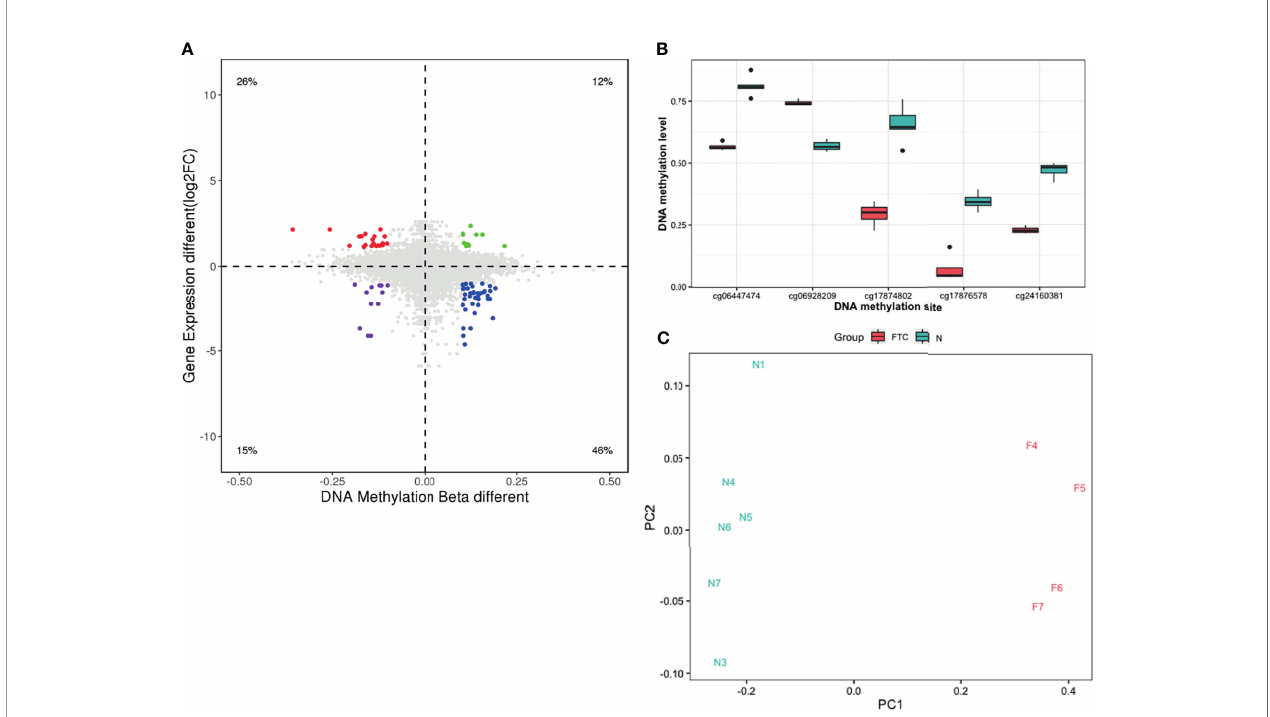
FIGURE 3 | (A) The result of correlation analysis showing differentially methylated sites were signi fi cant between FTC and BTL while inversely correlated with gene expressions. (B) Box plot showing signi fi cant different methylation levels of the 5 selected methylated sites in FTC patients compared with the BTL patients in discovery dataset. (C) Primary component analysis (PCA) shows FTC and BTL samples can be separated into two groups correctly when using the 5 selected methylation